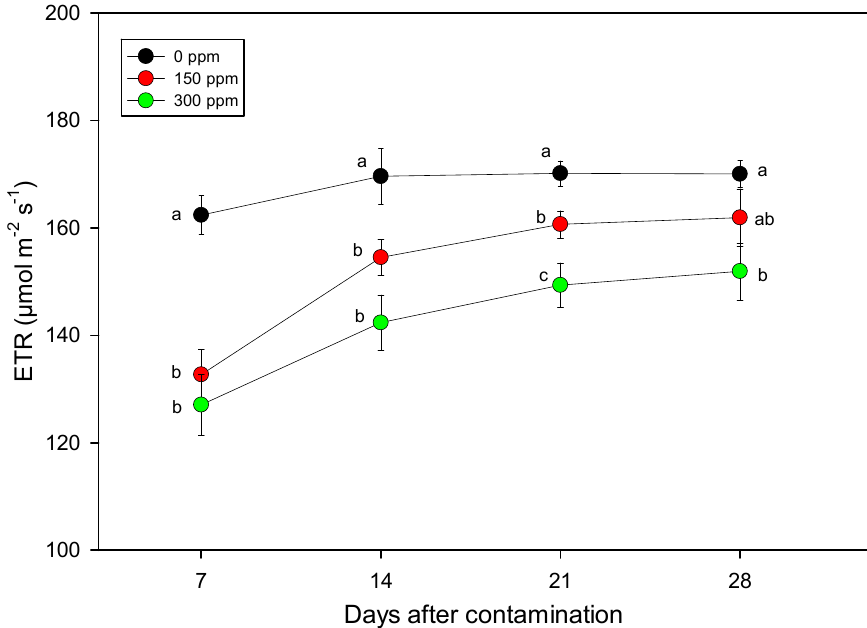
Figure 11. Time course of the electron transport rate (ETR) in Arundo plants treated with different copper concentrations (0, 150, and 300 ppm) for 28 days. Data of electron transport rate (ETR) measured at steady-state with a photosynthetic photon flux density (PPFD) of 1000 µmol m − 2 s − 1 is shown after 7, 14, 21, and 28 days after contamination. Data points and vertical bars represent means (n = 8) ± S.E., respectively. One-way ANOVA was applied and for a given duration different letters indicate significant difference according to LSD test ( p ≤ 0.05).